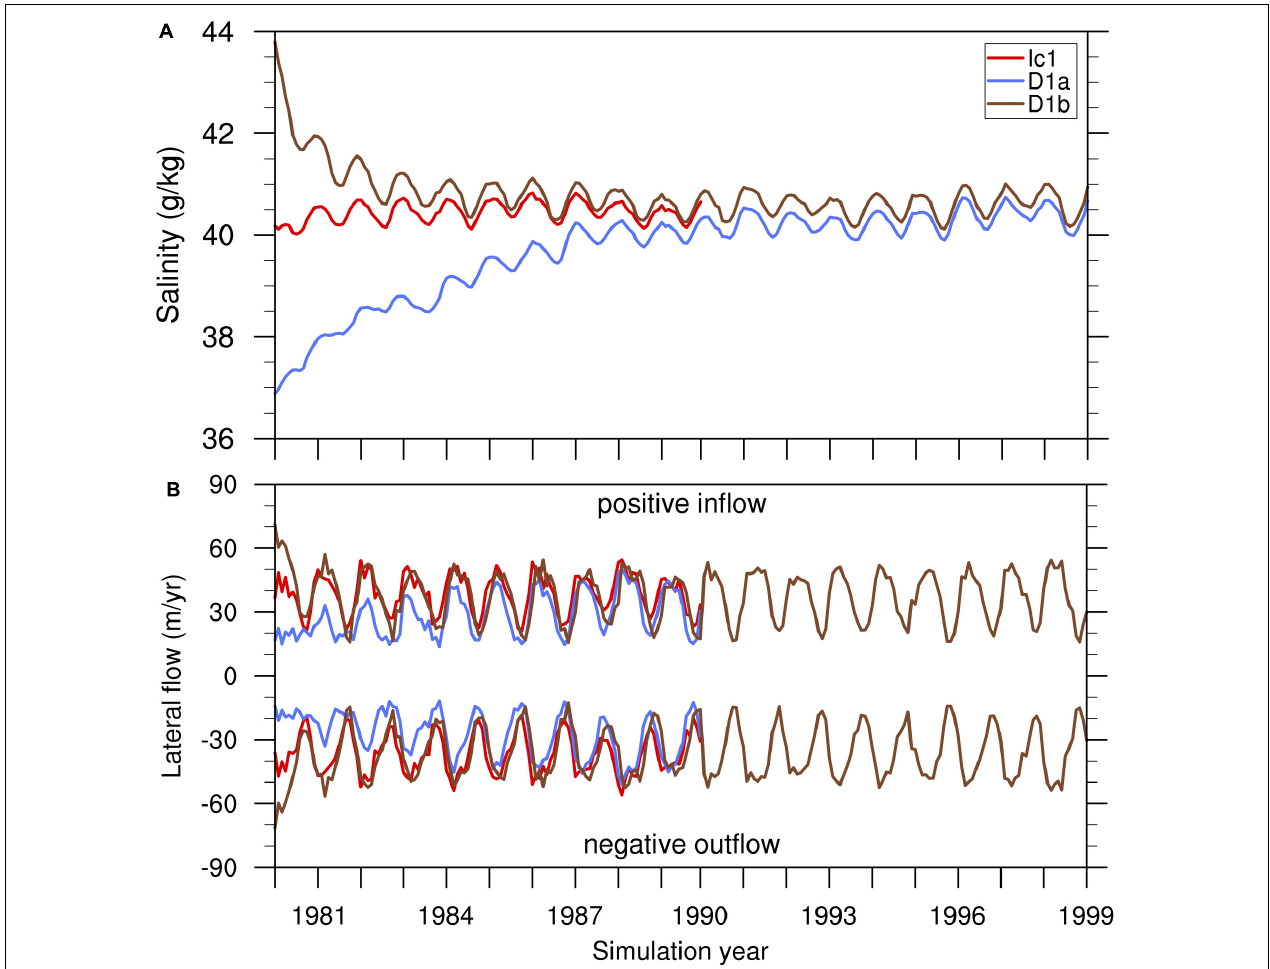
FIGURE 8 | Simulated (A) Gulf monthly basin-average salinity in Ic1, D1a, and D1b experiments; and (B) the corresponding lateral volume inflow and outflow. See Table 1 for experiment design details.